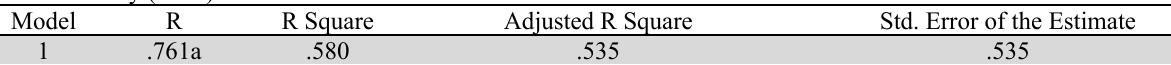
Model Summary (ROE)